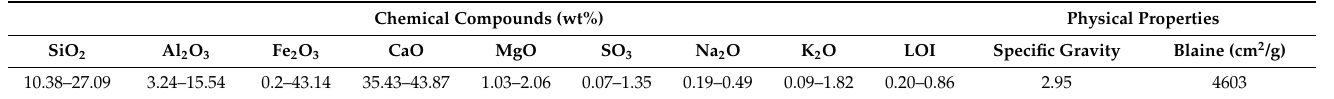
Figure 4. Worldwide production of GGBS and source; data from [43] . Table 2. Chemical composition of